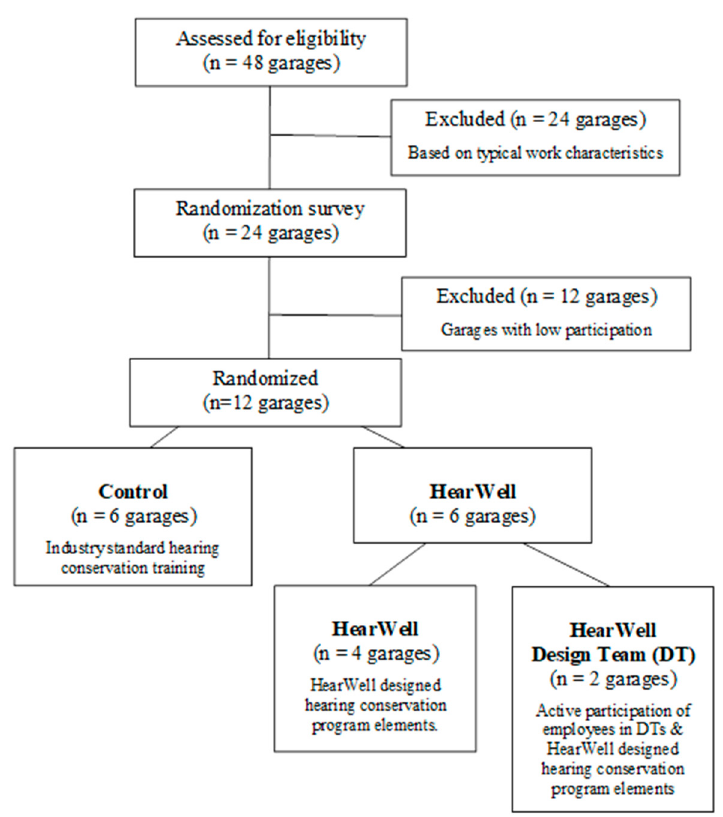
Figure 1. Flow diagram of the allocation of Department of Transportation maintenance garages into study arms.